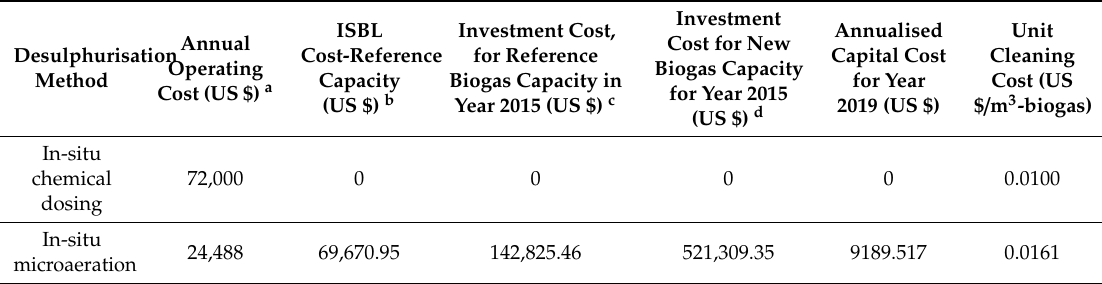
Table 5. Estimated ISBL cost, investment cost, annualised capital cost, and total operating cost for desulphurisation processes of in-situ chemical dosing and microaeration.